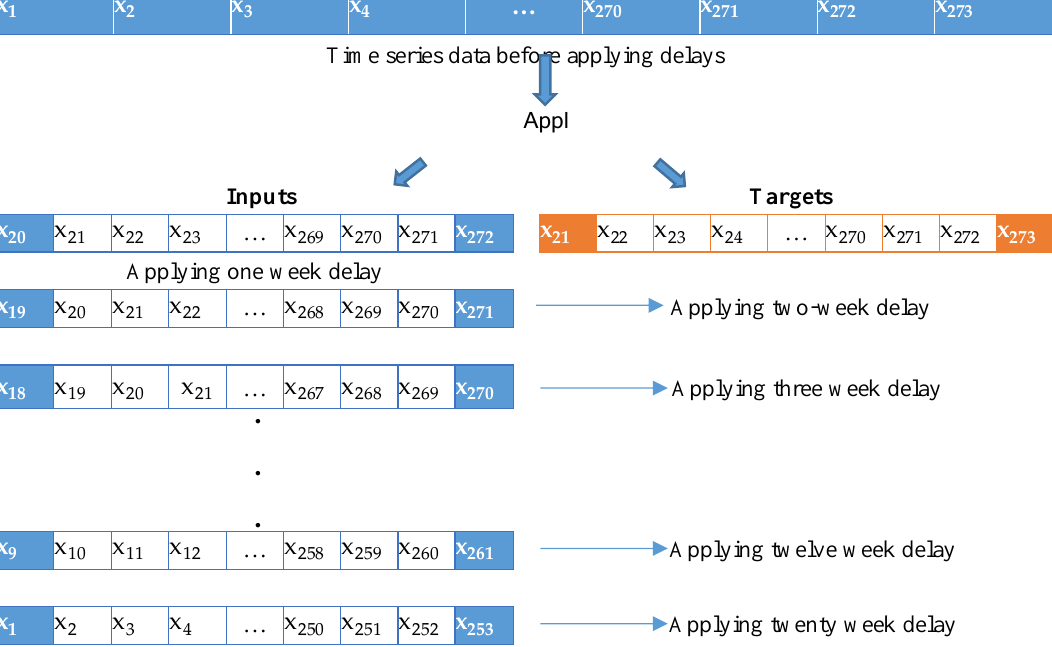
Fig. 5. Applying delays on time series